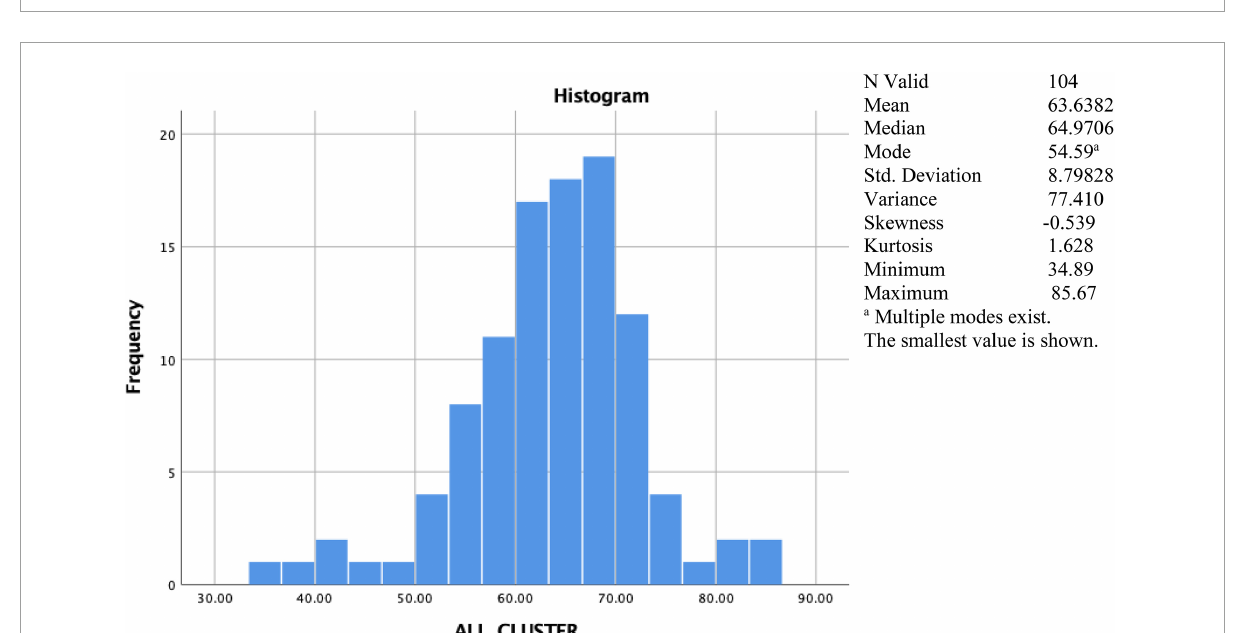
FIGURE3 The mode value of each indicator.